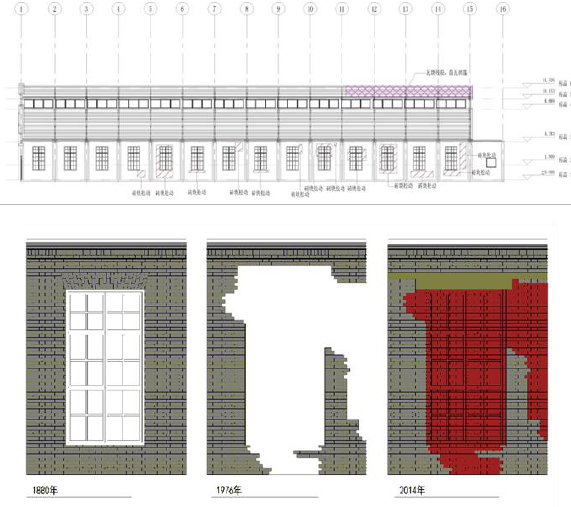
Figure 7 ． The wall damage documentation and partial inner wall changes of machinery engineering workshop, Dagu Dock of Beiyang Navy (International Research Center for Chinese Cultural Heritage Conservation of Tianjin University, 2014)